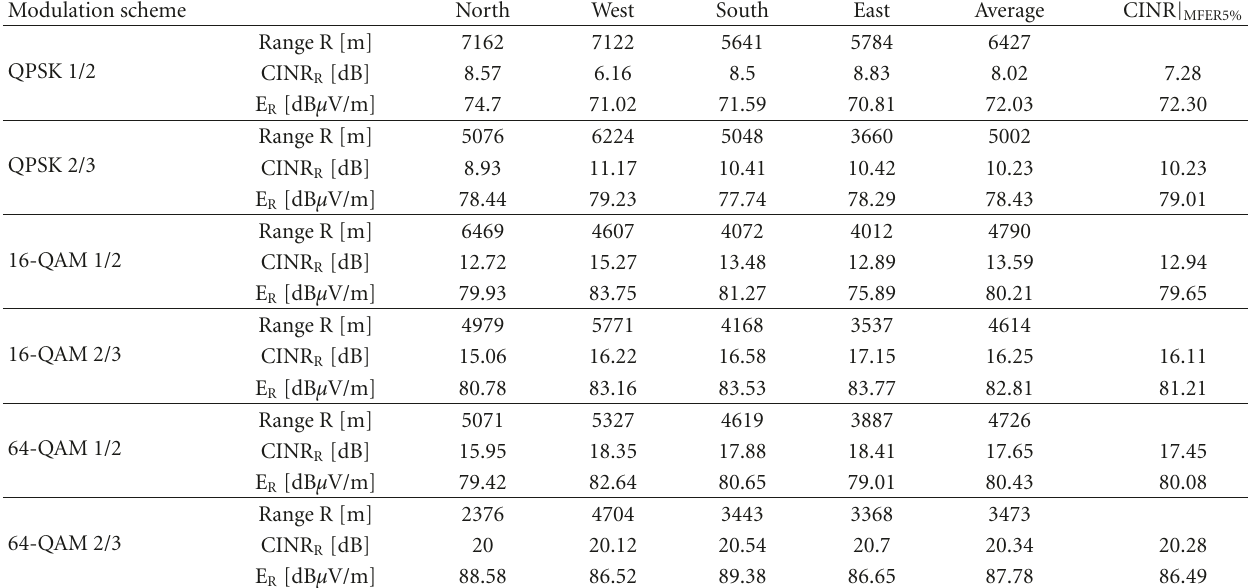
Table 4: Range R, corresponding CINR R and E R values for 95% valid reception, and MFER 5% values for routes along di ff erent wind directions and for di ff erent modulation